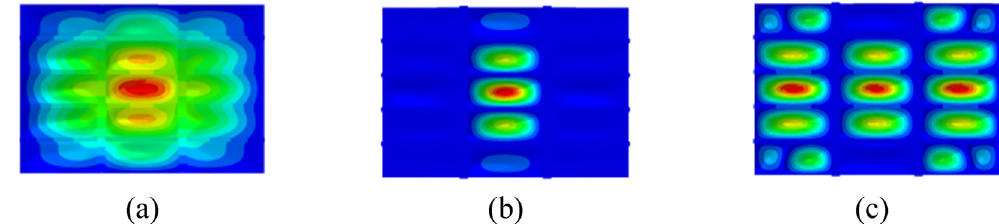
Figure 13: Vibration velocity response diagram of single point excitation: ( a ) 53 Hz, ( b ) 97 Hz, and ( c ) 103